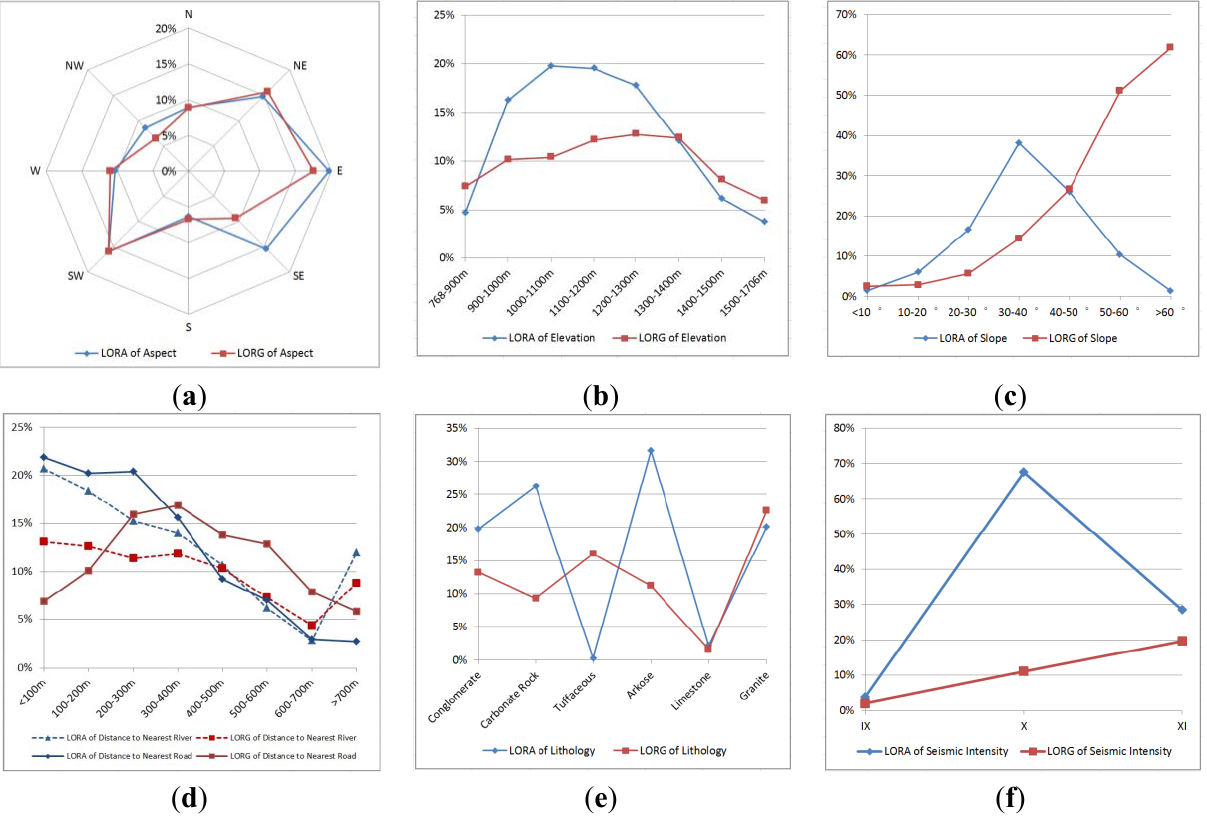
Figure 5. Relationships between landslides and the control factors: aspect, elevation, slope, distance to nearest river/road, lithology, and seismic intensity. ( a ) Aspect; ( b )